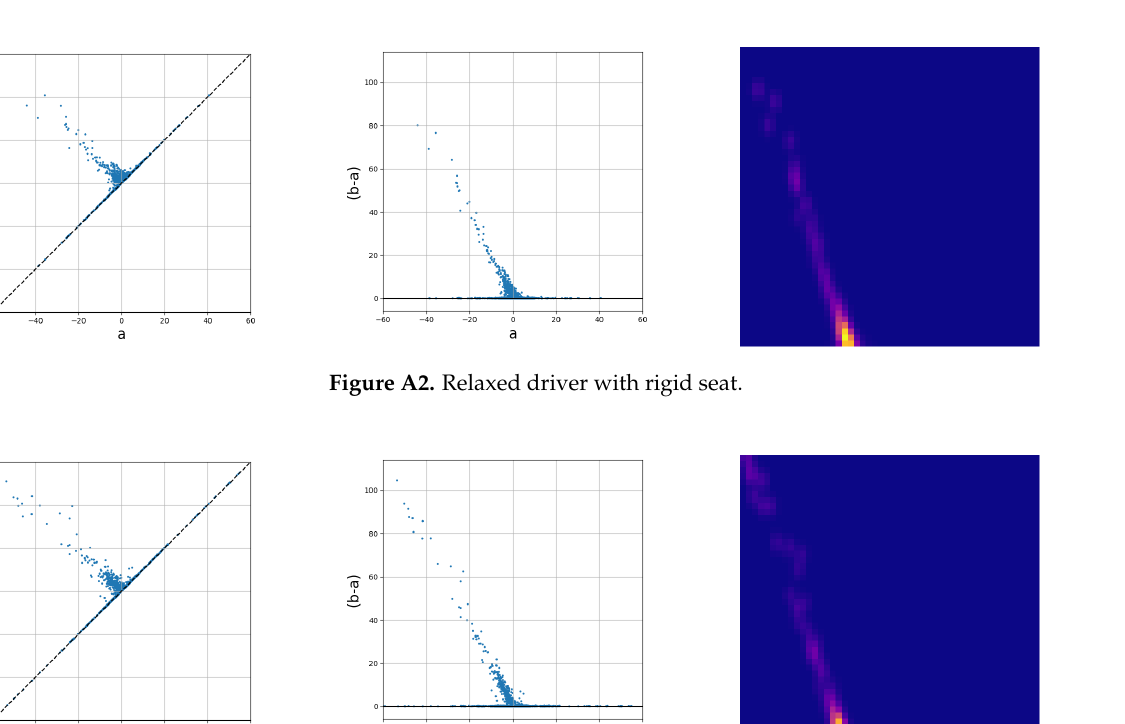
Figure A1. Relaxed driver with SAV seat.